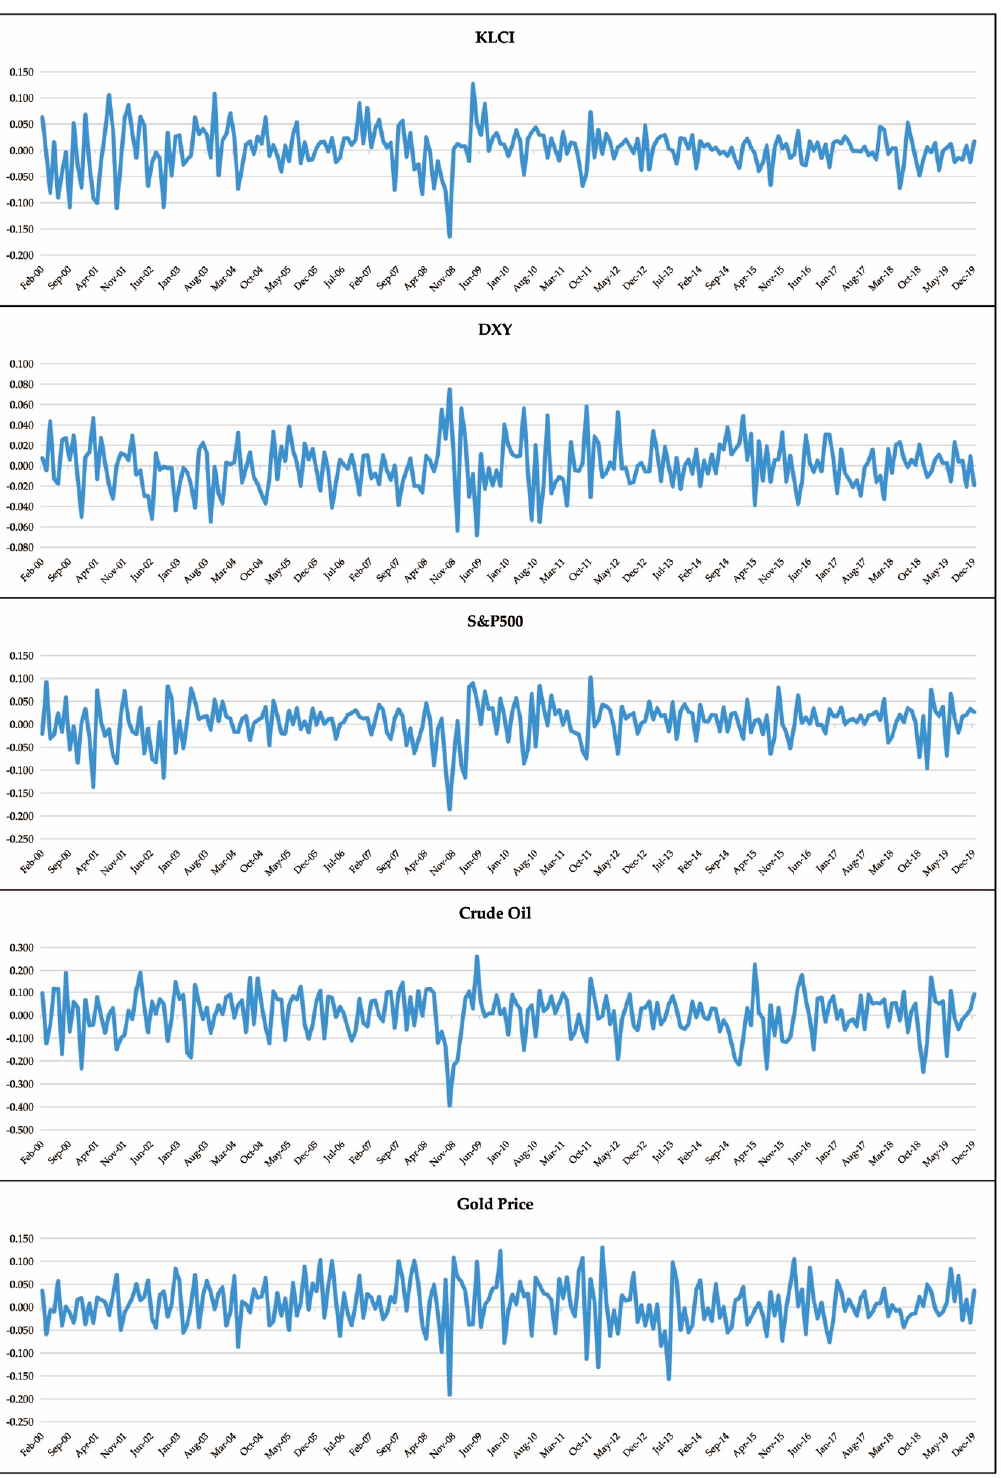
Figure 2. Monthly volatility for tourist arrivals into Malaysia and five financial news shocks.